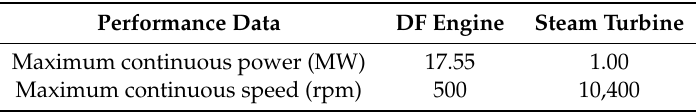
Table 1. Engines performance data.